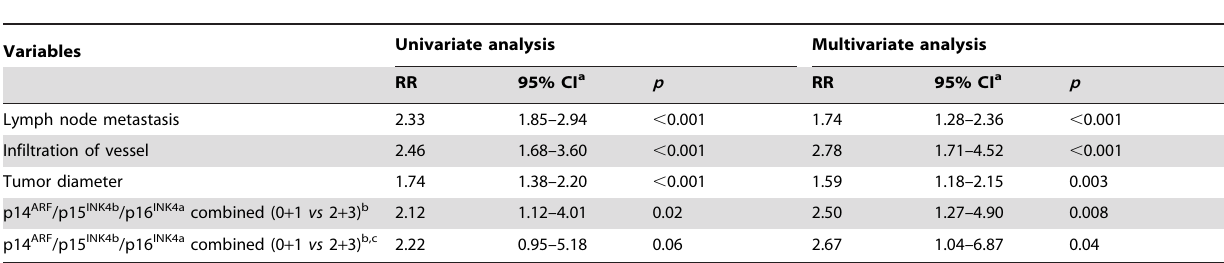
Table 3. Relative risk (RR) of dying from vulvar